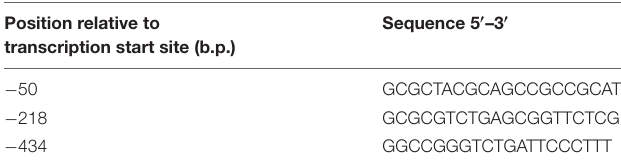
TABLE 1 | The sequences of sgRNA targeting the RPA1 promoter. Position relative to transcription start site